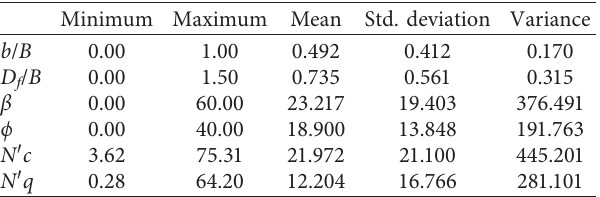
Table 2: Statistical analysis of the generated database.